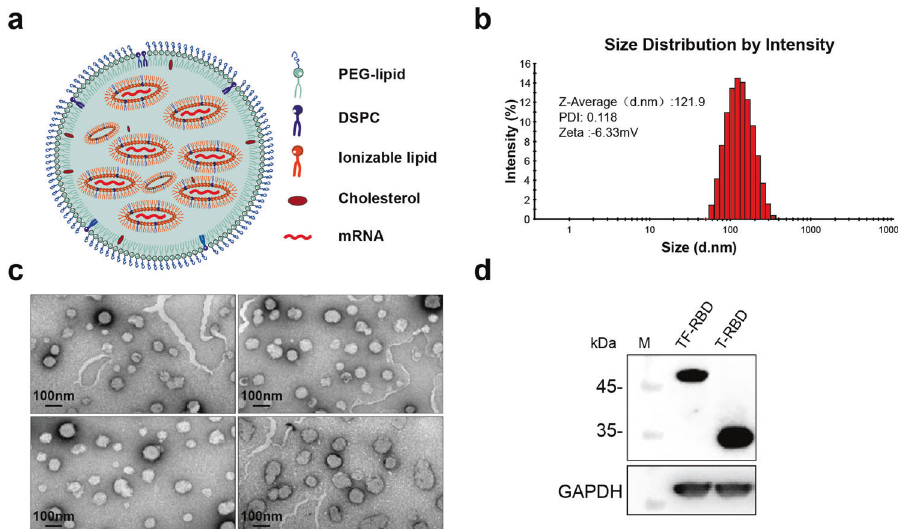
Fig. 2 Formulation and physical properties of liposomal nanoparticles (LNPs) for codelivery. a LNPs were synthesized from PEG-lipid (1.5 mol/ mol), DSPC (10 mol/mol), ionizable lipid (50 mol/mol), and cholesterol (38.5 mol/mol) at a speci fi c ratio. b The particle size, uniformity, and zeta potential of the LNPs were measured by a Malvern particle size instrument. c TEM images of the LNPs (scale bar, 100 nm). d The mRNA expression of the LNPs (T-RBD and TF-RBD proteins) in HEK293T cells was analyzed by western